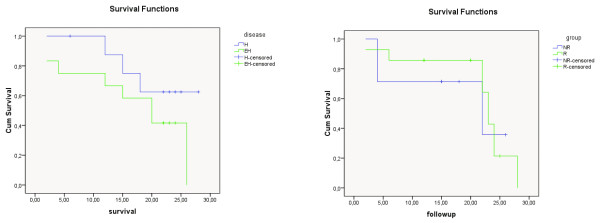
Cumulative survival curves of the R, NR, H and EH subgroups in the HCC group. Survival: months, R: responder, NR: nonresponder, H: hepatic, EH: extrahepatic.